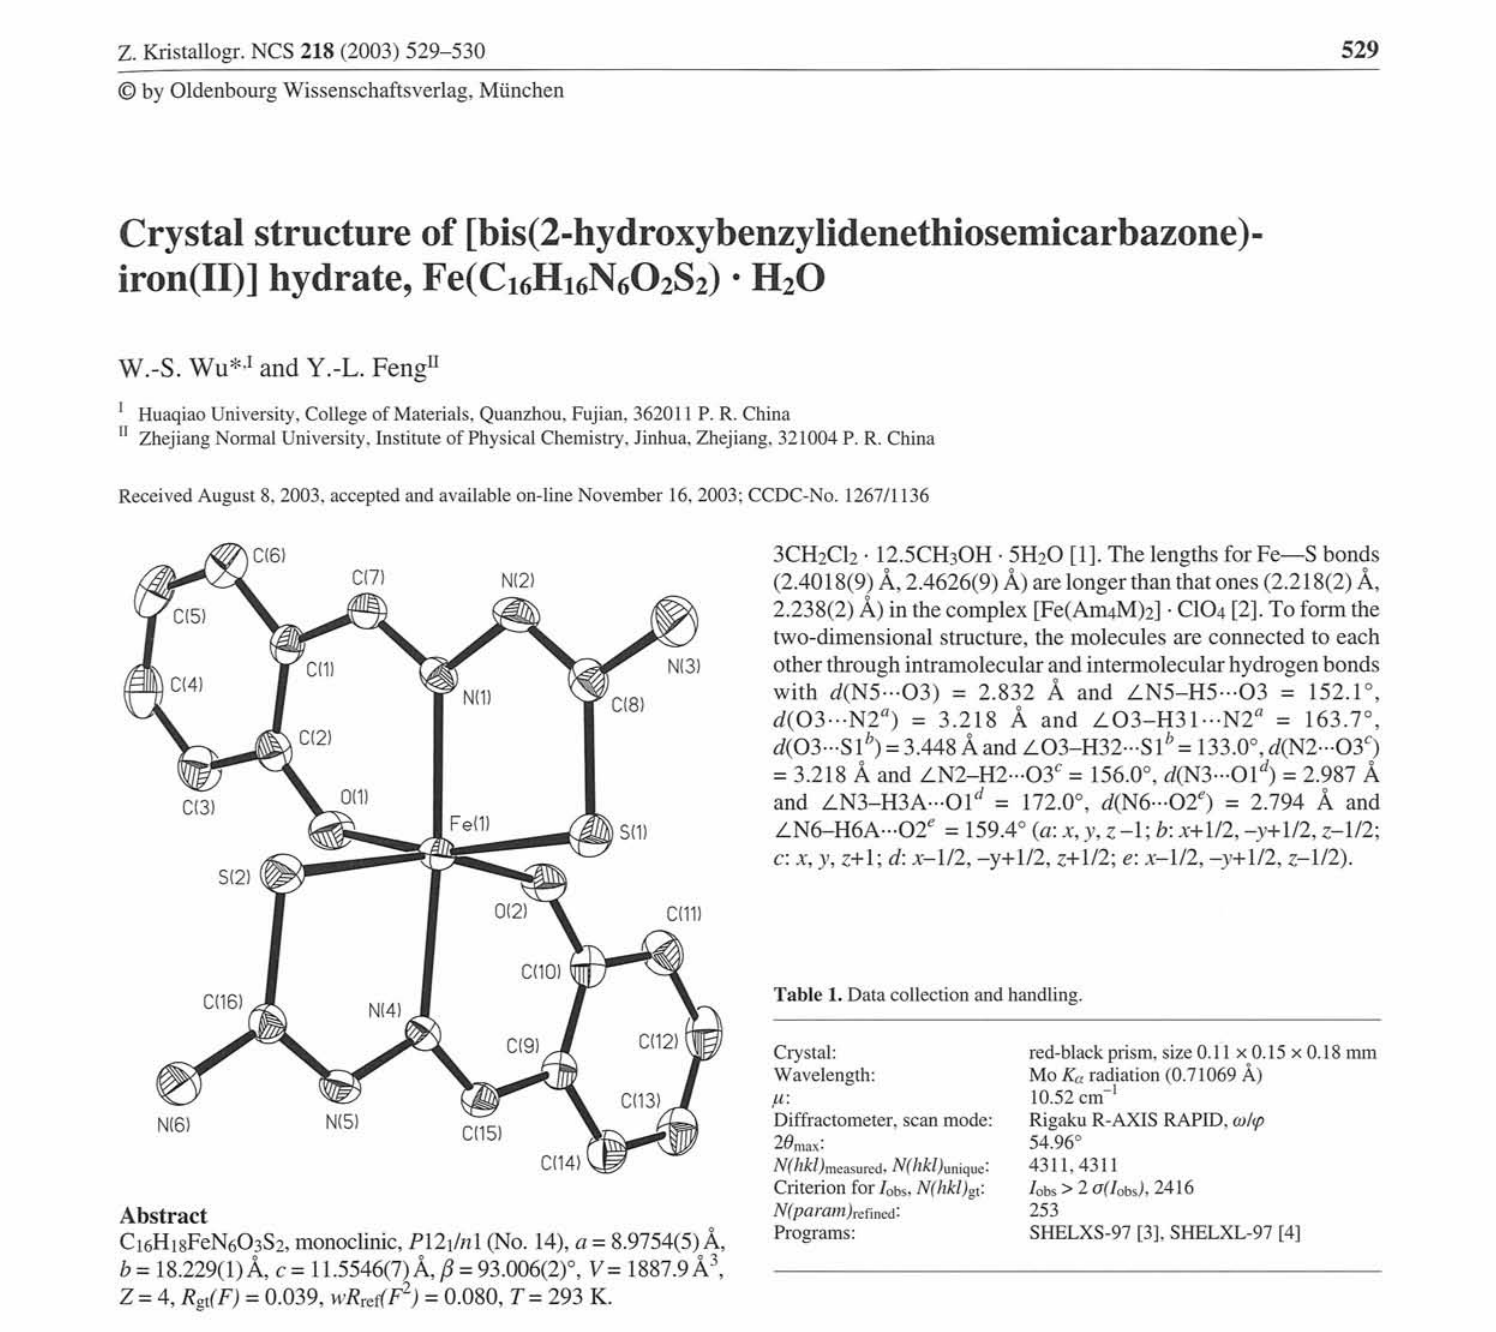
Table 2. Atomic coordinates and displacement parameters (in